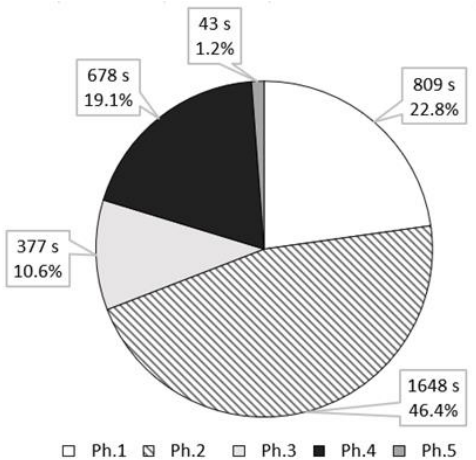
Figure 5. Average durations of different combustion phases within the overall process.